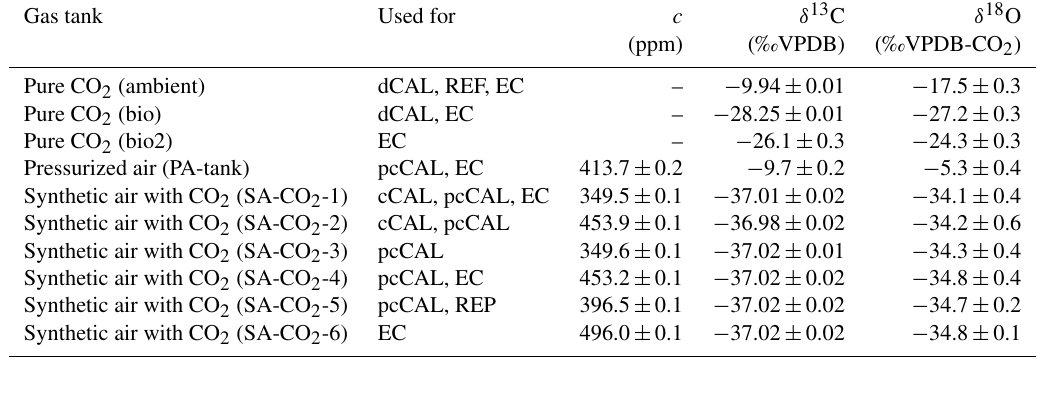
Table 3. Known CO 2 concentrations c and δ values for gas tanks used for calibration and instrument performance measurements. All measured concentrations and δ values refer to measurements that were performed at the Max Planck Institute for Biogeochemistry in Jena and the δ 13 C values of the two pure CO 2 tanks. The pure CO 2 tanks bio and ambient were additionally measured with IRMS at the Geoscience Center in Göttingen (Isotope Geology Division, Göttingen University) for their 13 C composition. Abbreviations for the purpose of the tanks: cCAL, concentration calibration; dCAL, δ calibration; REF, referencing; EC, evaluating calibration; pcCAL, post-concentration calibration; REP, repeatability measurement.